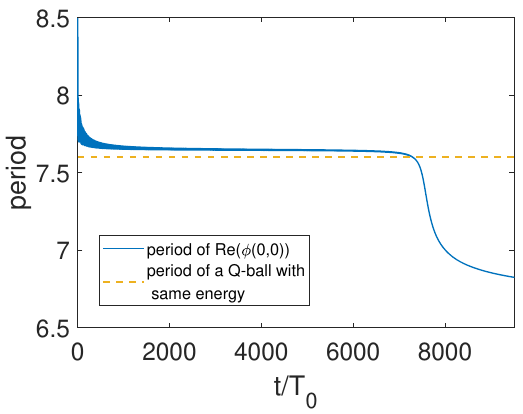
Figure 11. Evolution of the period of the real part of the field φ at the origin ( x = 0 , y = 0) . All the settings are identical to figure 8. The orange dashed line is the oscillation period of an elementary Q-ball with the same energy as the CSQ. Note that if we prepare the CSQ with elementary Q-balls with different frequencies, the period of the resulting CSQ remains the